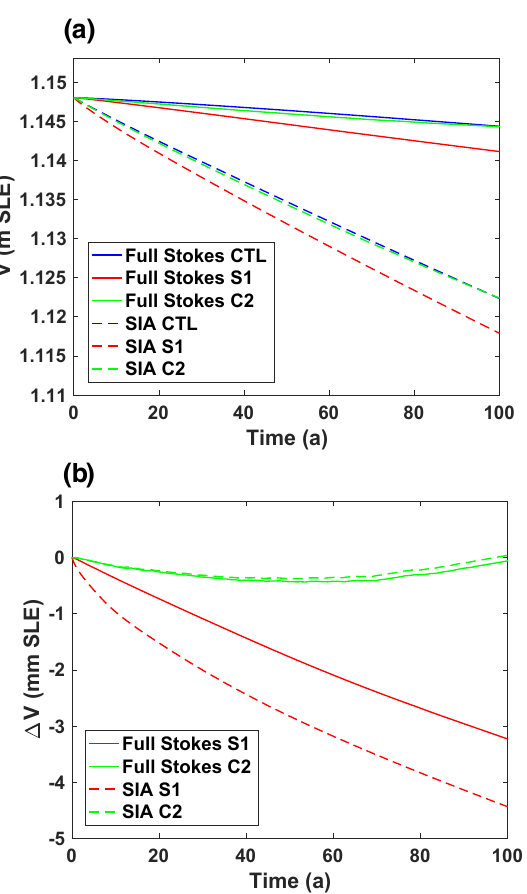
Figure 5. (a) Ice volume ( V ) simulated with FS and SIA for ex- periments CTL (constant-climate control run), S1 (basal sliding ex- periment) and C2 (surface climate experiment) and (b) ice volume relative to CTL ( (cid:49)V ) for experiments S1 and C2. The volumes are expressed in sea level equivalents (SLE). t = 0 corresponds to the year